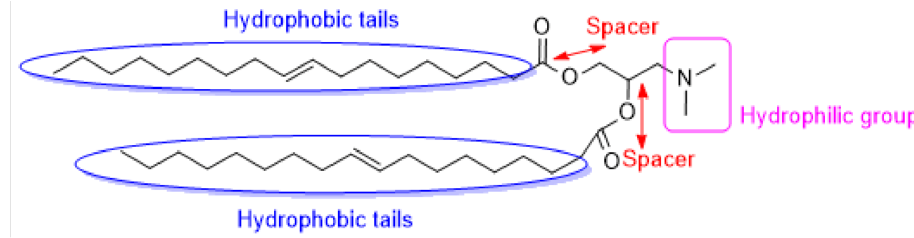
Figure 2. Chemical structure of DODAP, a cationic ionizable